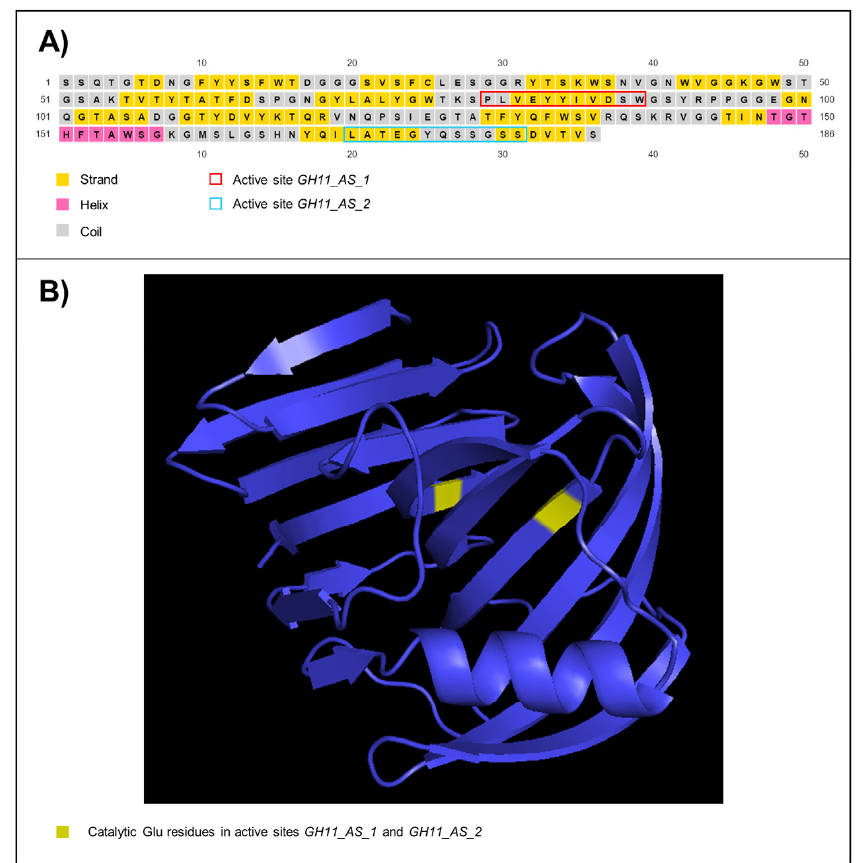
Figure 3. HtpXyl endo- β -1,4-xylanase-like from uncharacterized symbiont protist of Heterotermes tenuis . ( A ) Secondary and ( B ) Tertiary structure.